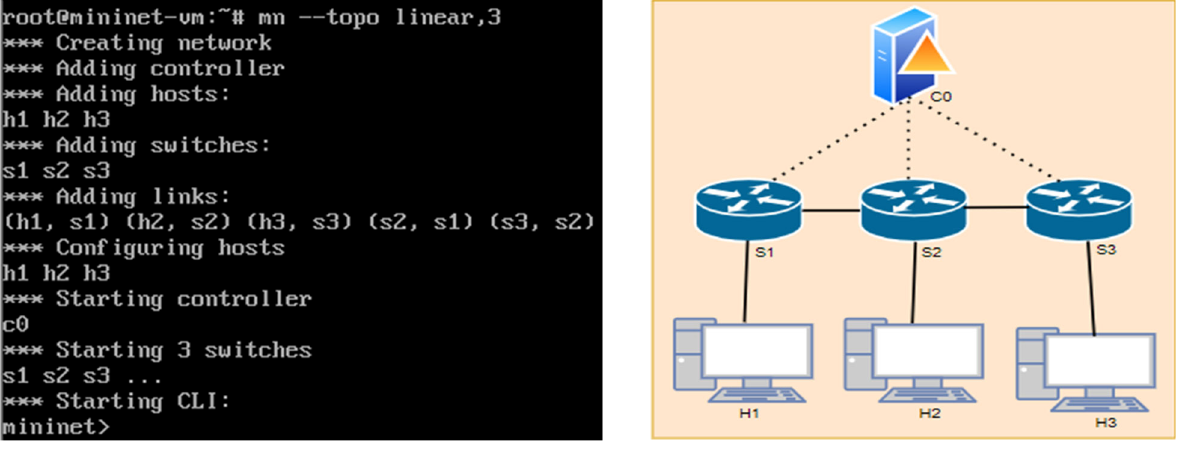
Figure 16. Linear topology Mininet command: mn ‐‐ topo linear,3.